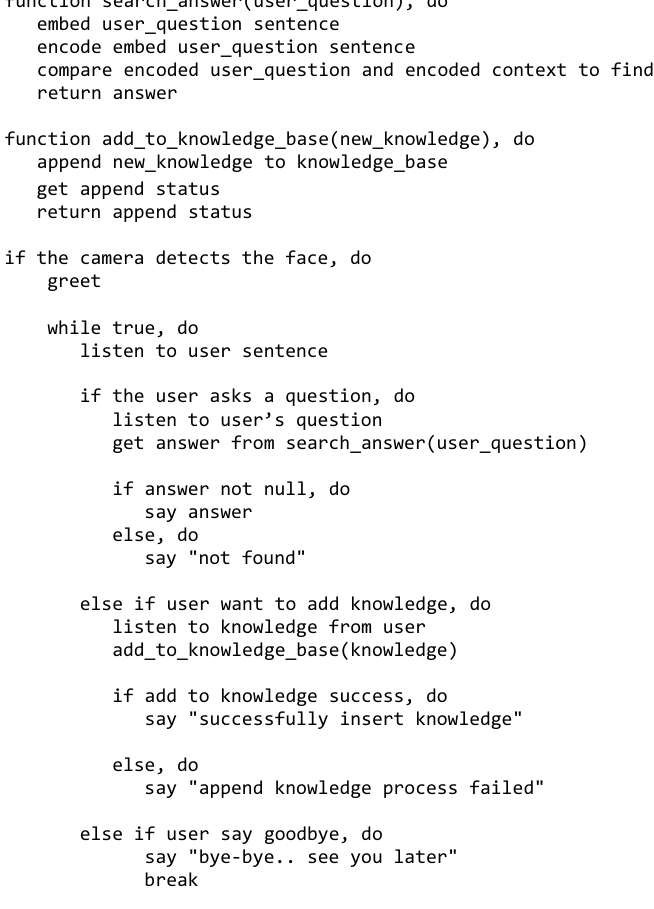
Algorithm 1. Self-Learning for Humanoid